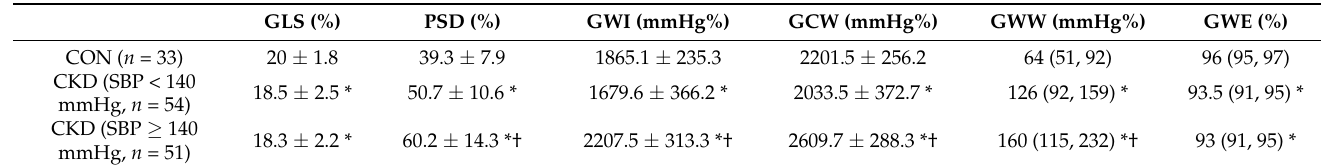
Table 4. Left ventricular global longitudinal strain and myocardial work according to the subdivision analysis of the